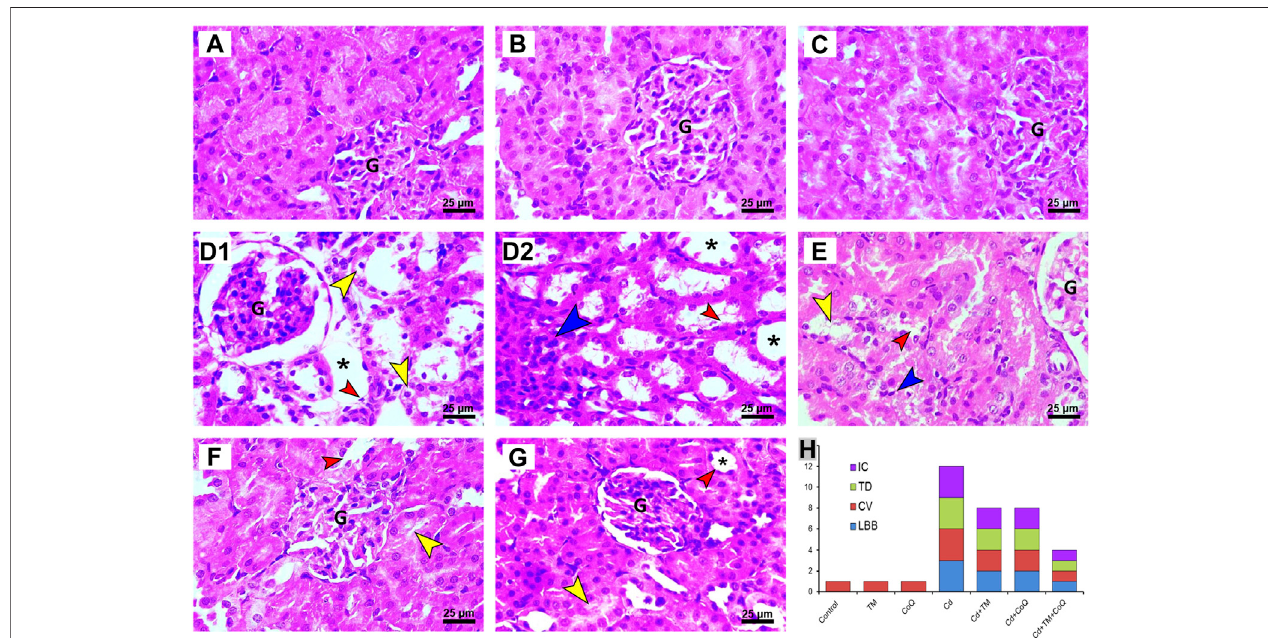
FIGURE 6 | Histopathology of kidney tissue in Control and Cd-, TM-, and CoQ-treated groups. Normal nephrons were observed in Control (A) , TM-treated (B) , and CoQ-treated (C) rats.Cd (D1 and D2): kidneysectionofCd-treatedgroupshowinglossofnormalrenalarchitecturewithlossofbrush border(redarrow), vacuolated cytoplasm (yellow arrow) in the epithelial lining of renal tubules, dense in fl ammatory cell in fi ltration (blue arrow), and severe tubular dilation (asterisk). Cd + TM (E) and Cd + CoQ (F): dramatic improvement of renal architecture was observed when Cd was co-administered with TM or CoQ, indicated by mild lesions in certain renal tubules. Cd + TM + CoQ (G): rats treated synchronously with Cd and both TM and CoQ, expounded that renal tubules were reverted close to normal. (H) Ordinal scoring of recorded histopathological alterations in the renal tissue. (CV, cytoplasmic vacuolation; G, glomerular tuft; IC, in fl ammatory cell in fi ltration; LBB, loss of brush border; TD, tubular dilatation; H&E, hematoxylin and eosin; scale bar = 25 µM.)